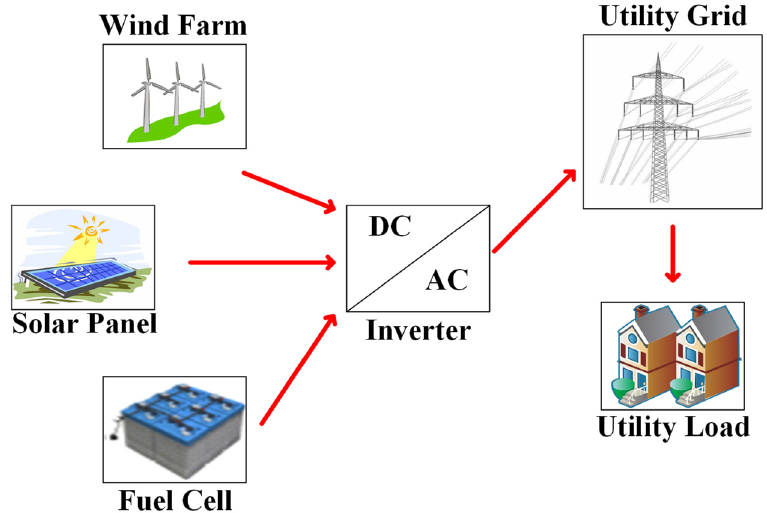
Figure 1. Distributed Renewable Energy (RE) based Generation Network.